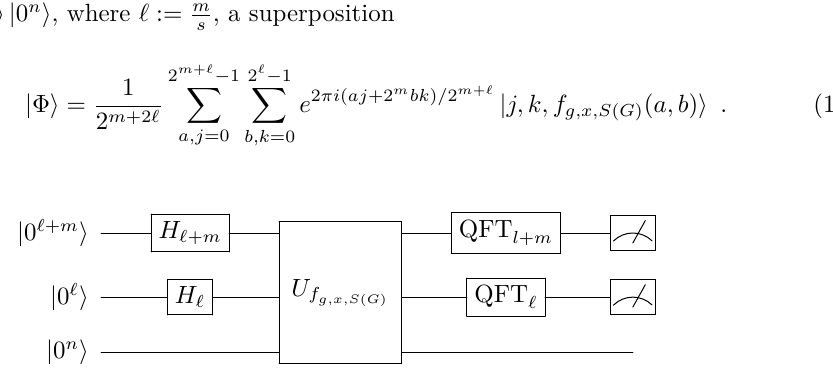
from Figure 13 computes on input